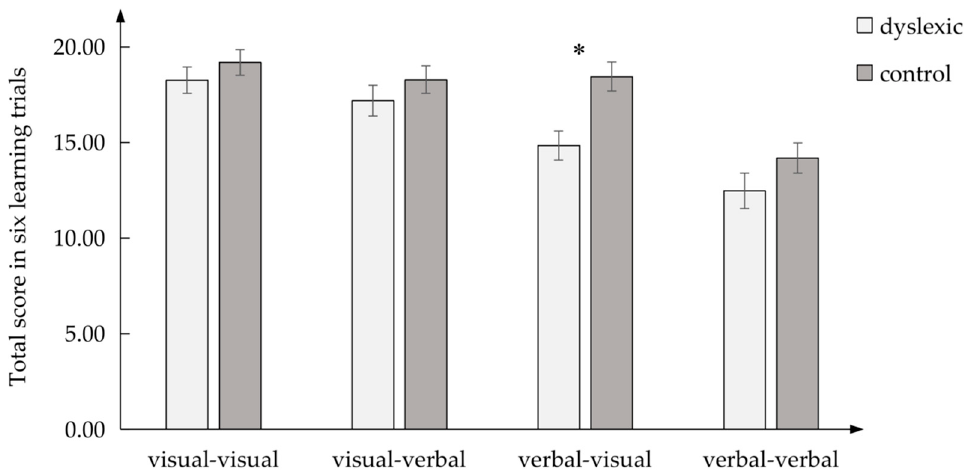
Figure 4. The late learning effect in four PAL conditions between dyslexic and control groups; * p < 0.05